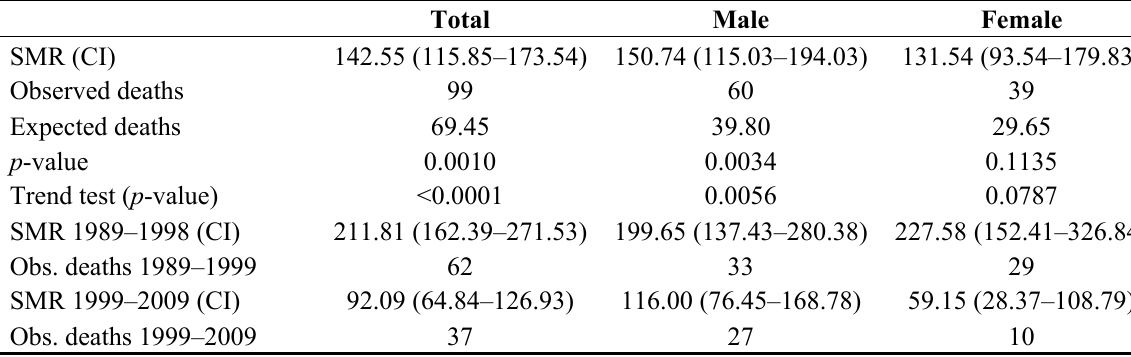
Table 2. Mortality in Milos compared to Cyclades prefecture for the total of respiratory diseases (ICD9 range: 460–519); years 1989–2009.